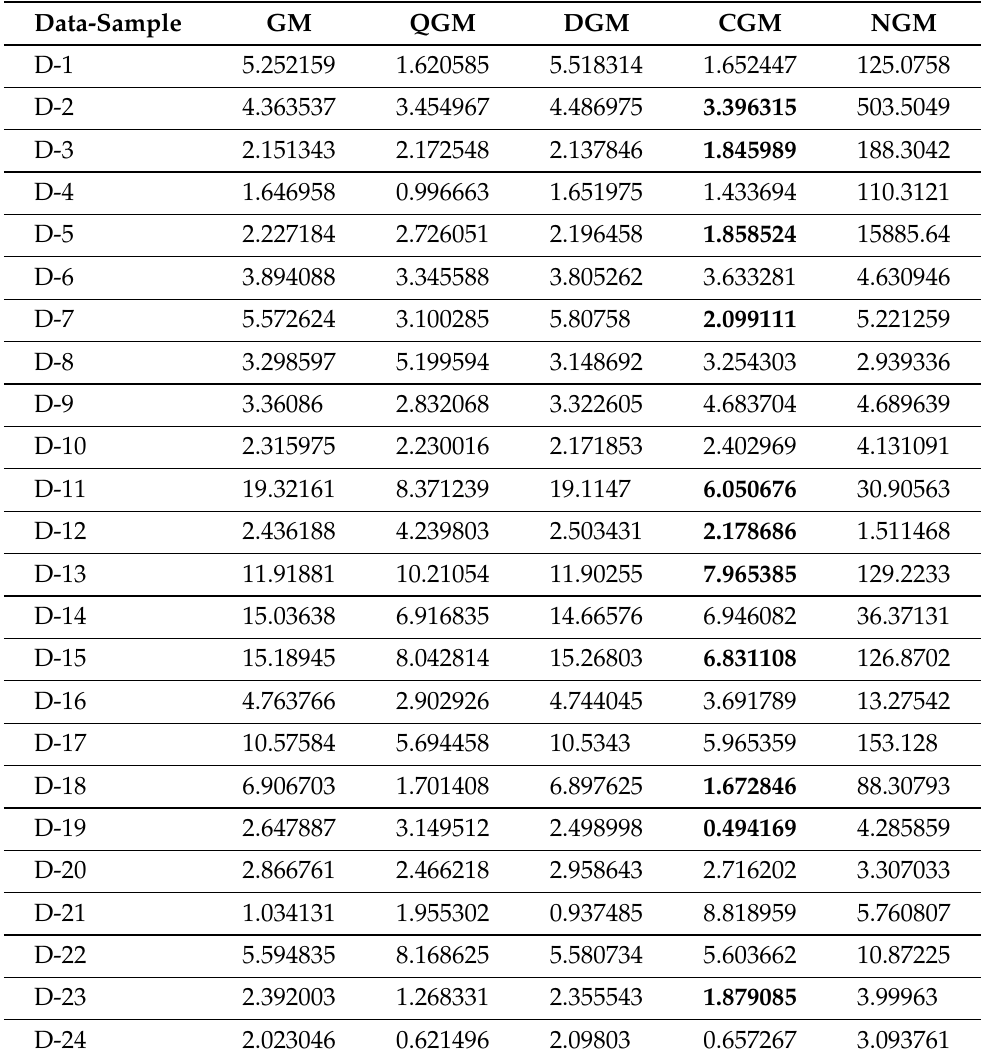
Table 5. Quartile-1 details of signals (D-1 to